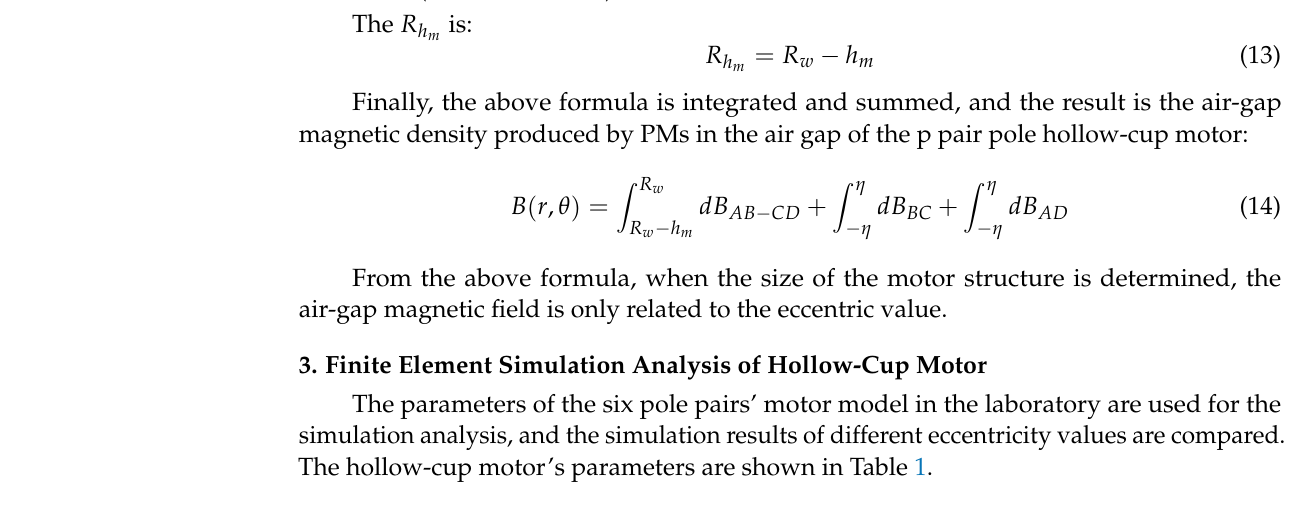
Table 1. Parameters of hollow-cup motor